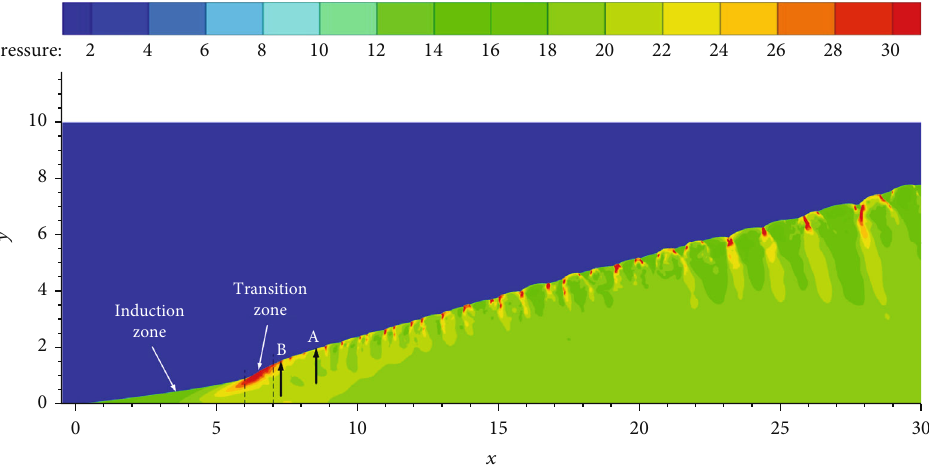
Figure 5: Pressure fi eld with E